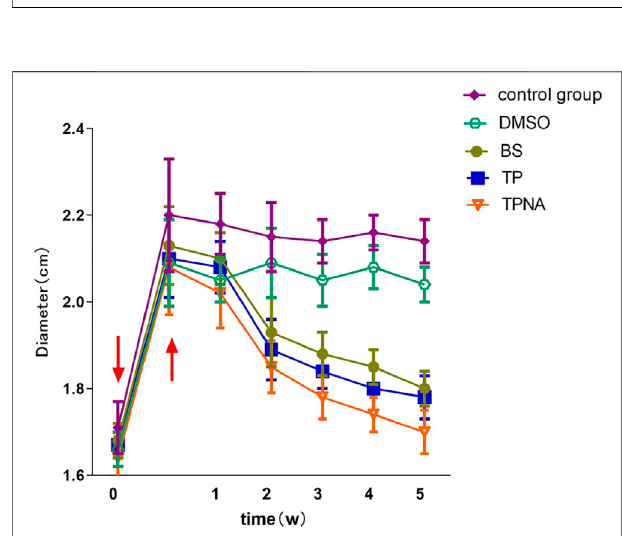
FIGURE 4 | Changes of knee joint diameter in each group of experimental rabbits. Induction by injection of ovalbumin into the articular cavity ( ↓ ). After 1 day, the diameter of the knee joint increased signi fi cantly ( ↑ ).